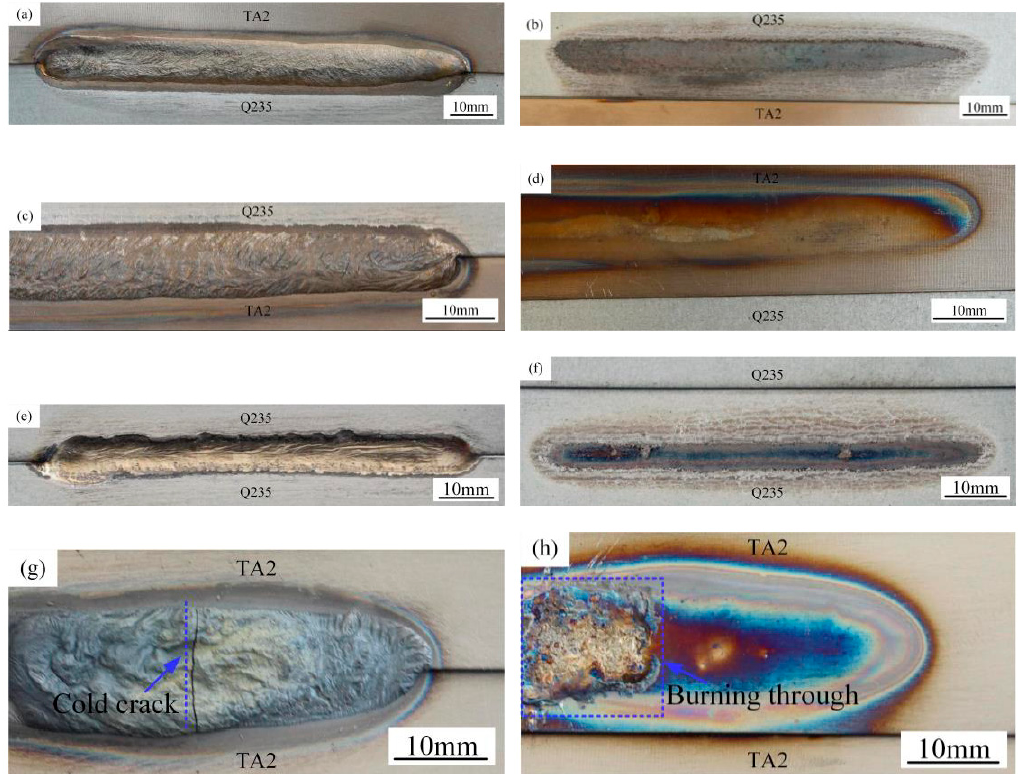
Figure 4. Weld appearance of ( a ) top view, ( b ) back view of Joint I (sample #1), respectively; ( c ) top view, ( d ) back view of Joint II (sample #2), respectively; ( e ) top view, ( f ) back view of Joint III (sample #3), respectively; and ( g ) top view, ( h ) back view of Joint IV (sample #4), respectively.